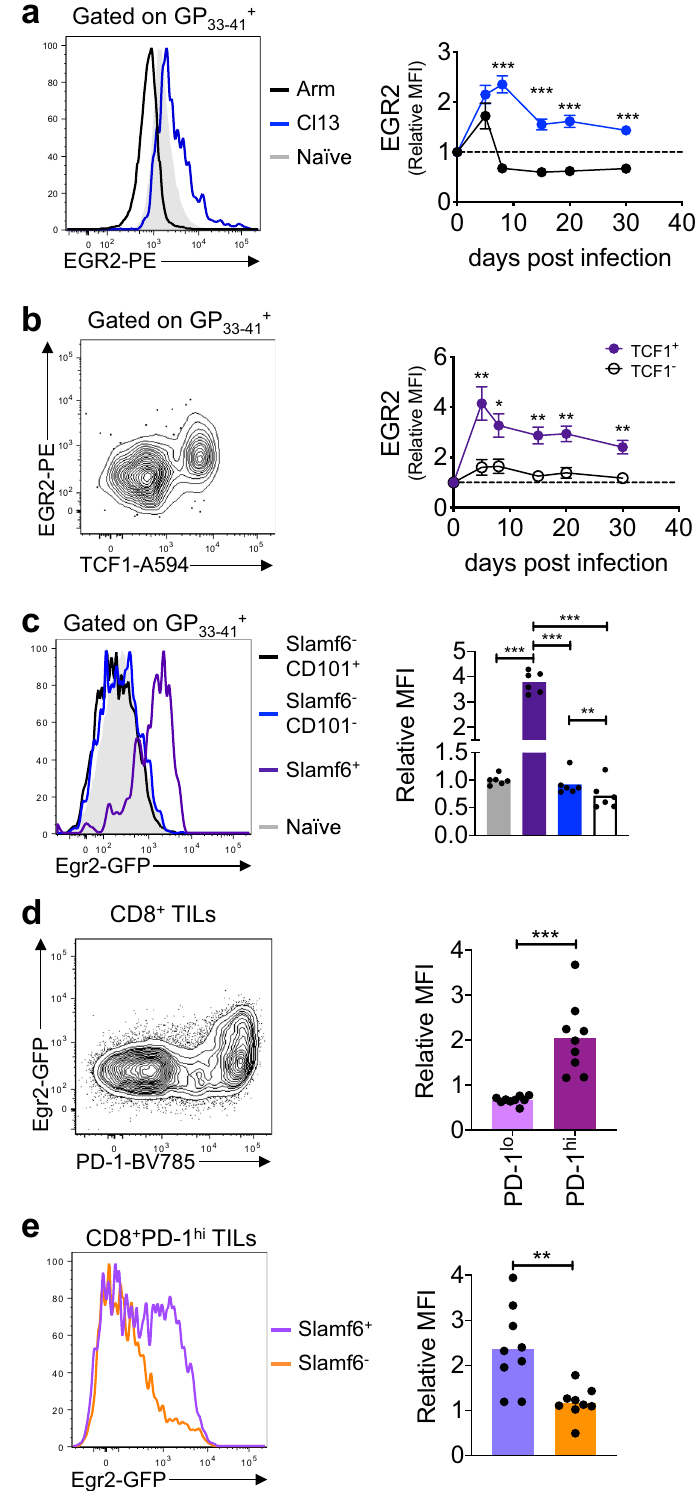
(Fig. 2a). Transfer of P14 cells from LCMV-Arm infection into LCMV-Cl13 infected hosts led to increased EGR2 expression relative to P14 cells transferred into control LCMV-Arm infected mice (Fig. 2b). In the reciprocal experiment, the transfer of P14 cells from LCMV-Cl13 infection into LCMV-Arm infected hosts